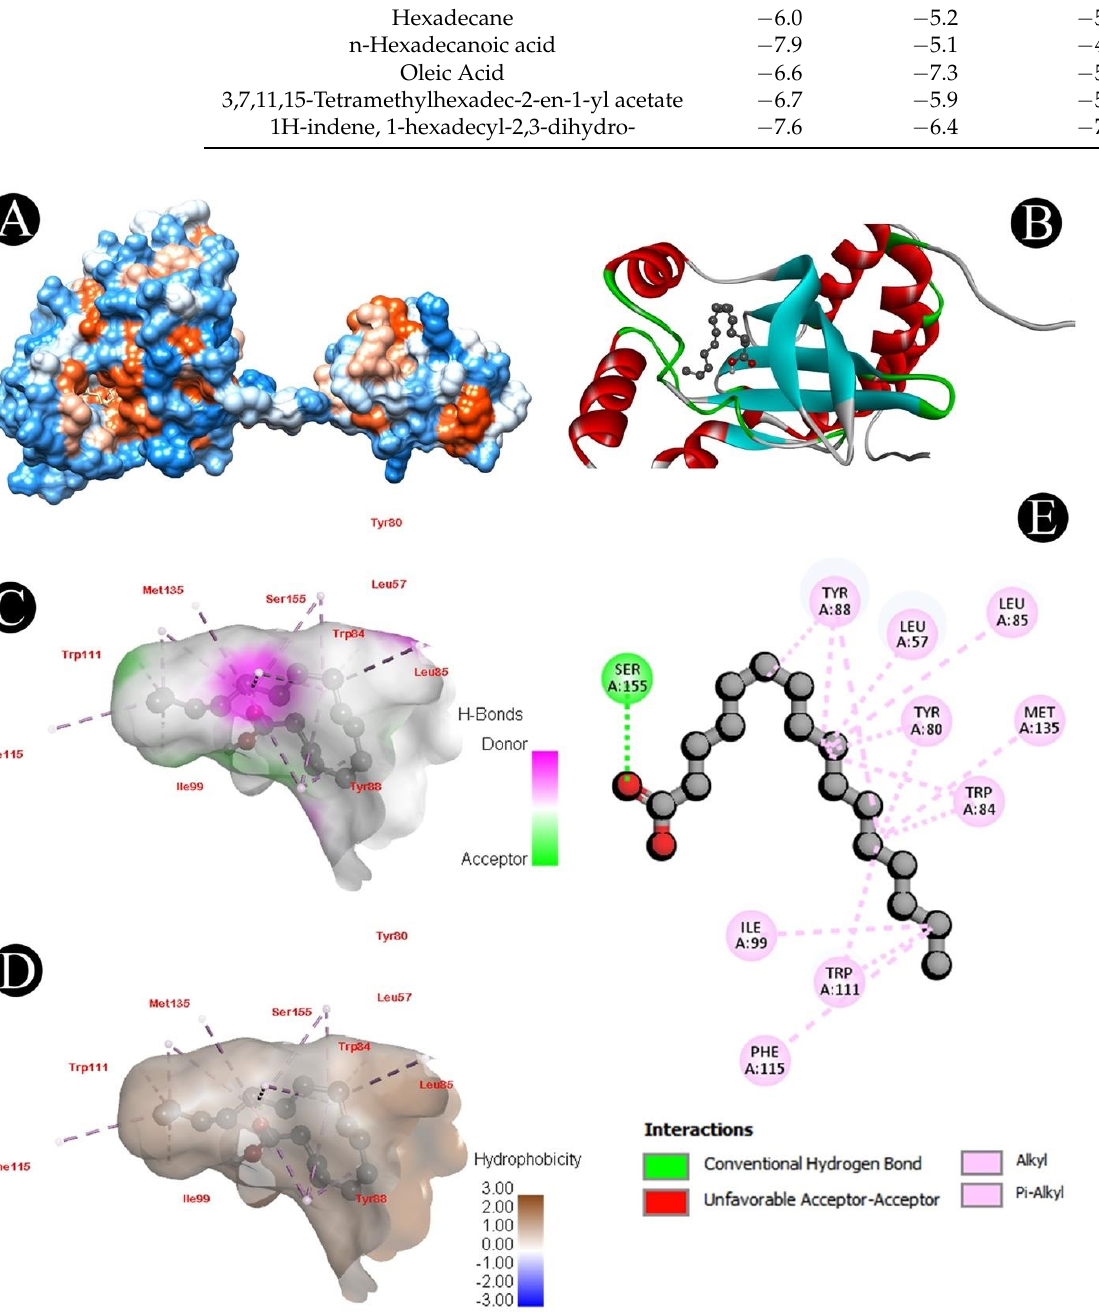
Figure 7. Visualization of the docking analysis of n-hexadecanoic acid binding with 3QP5. ( A ) Interaction of n-hexadecanoic acid with 3QP5. ( B ) Close-up of the interaction of n-hexadecanoic acid with 3QP5. ( C ) Visualization of hydrogen bond. ( D ) Visualization of hydrophobic interaction. ( E ) Two-dimensional representation describing the bindings of n-hexadecanoic acid with an active site of